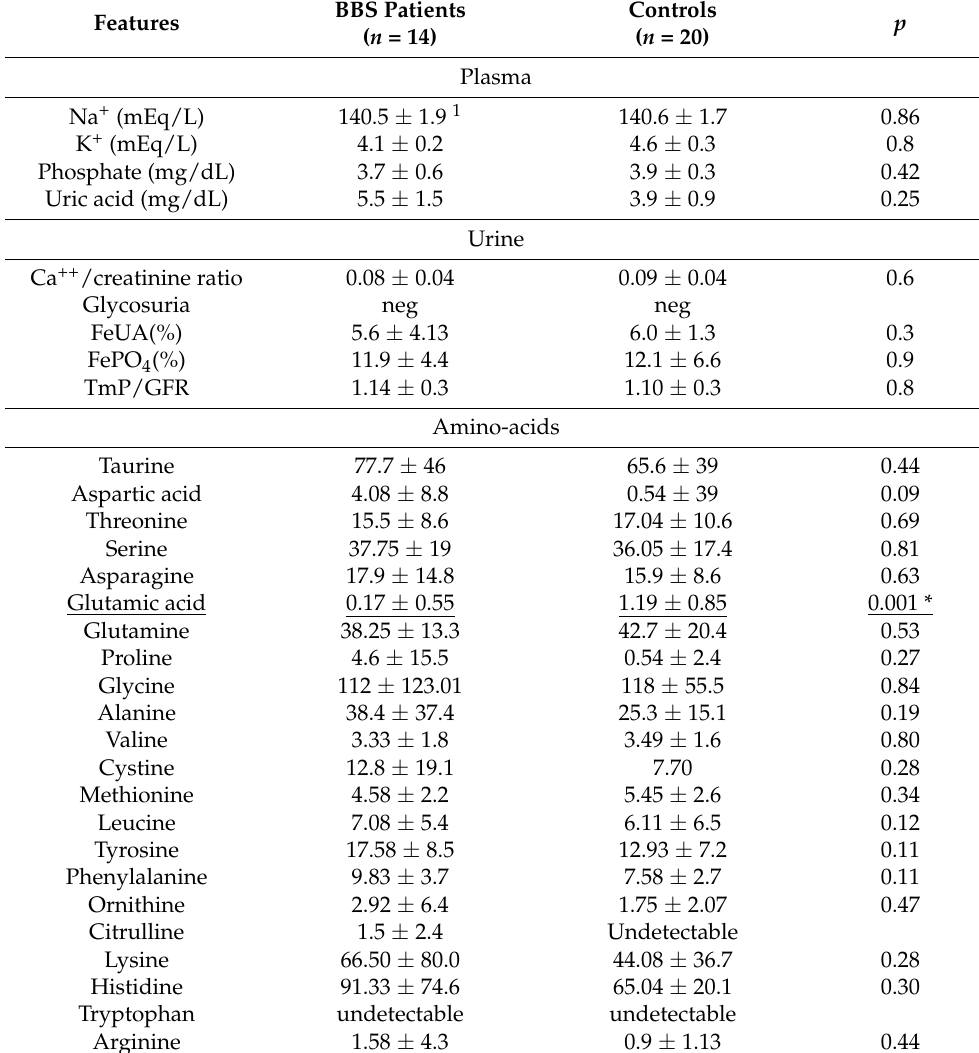
Table 3. Plasma and urinary markers of proximal tubule (PT)